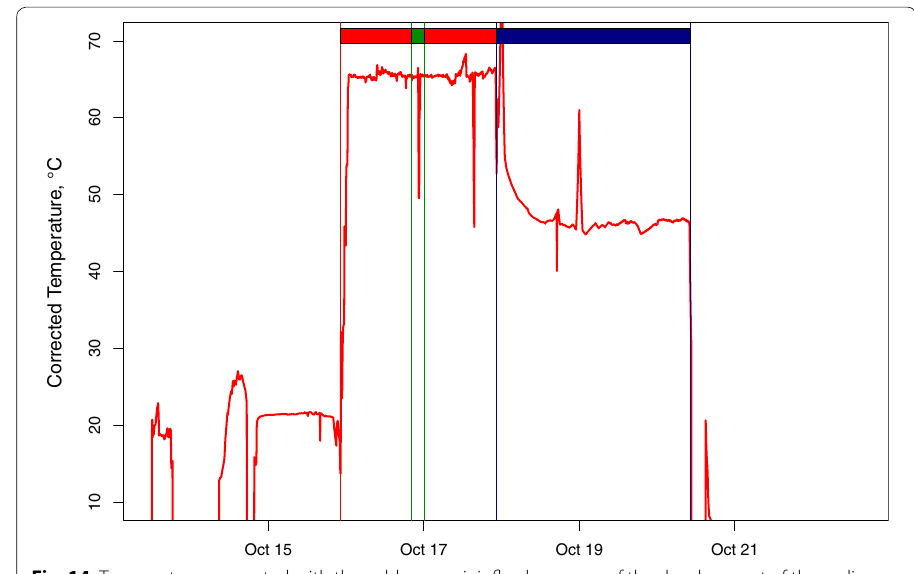
Fig. 14 Temperatures corrected with the cold reservoir influx by means of the development of the sodium ion concentrations during production stage 0 ( T Inj = 65 ◦ C ). The colored bars at the top symbolize injection (red), calibration of the probe (green) and production (blue) stage